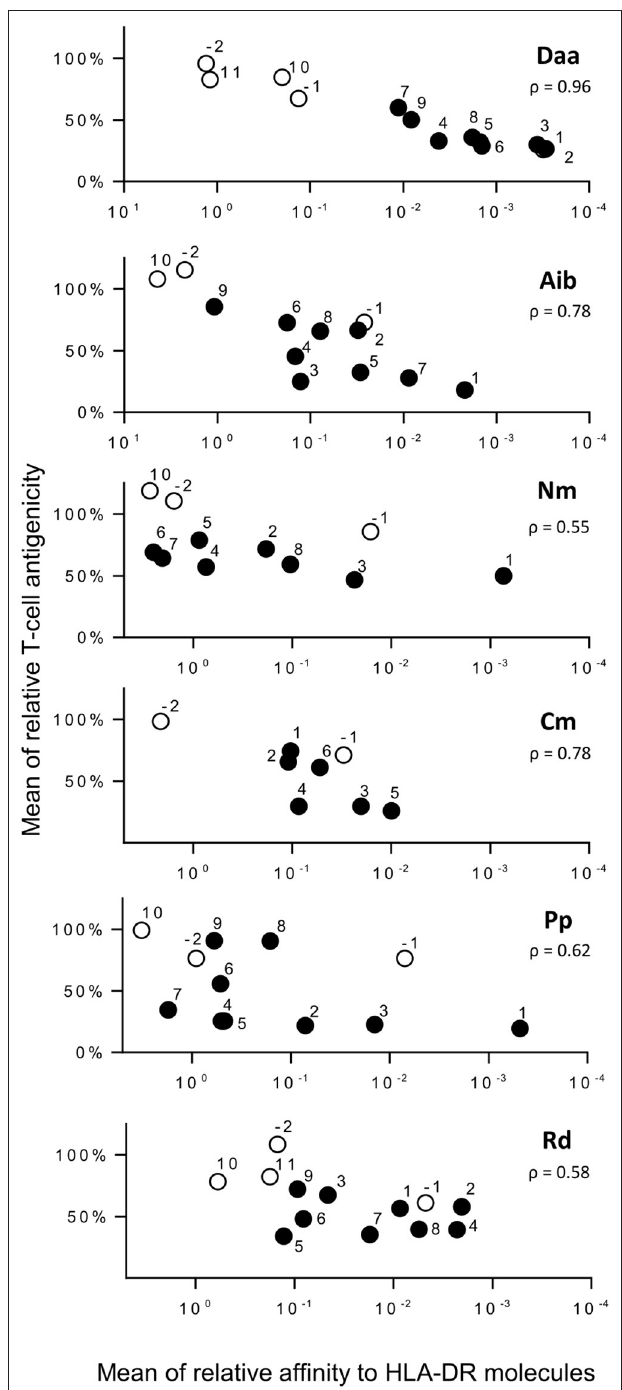
FIGURE 4 | Comparison of T-cell antigenicity of HA analogs and their binding to HLA-DR molecules. Relative T-cell reactivity with HA-specific T cells of each substitution (ratio of IFN- γ spot number of each analog to that of HA) is reported as a function of their mean relative affinities for HLA-DR molecules (mean ratio of IC 50 of analog to IC 50 of HA across the five HLA-DR molecules). Numbers refer to the position relative to the P1 anchor residue of HA. Positions within the core or within the flanking regions are in black and white, respectively. ρ refers to Spearman’s rank correlation